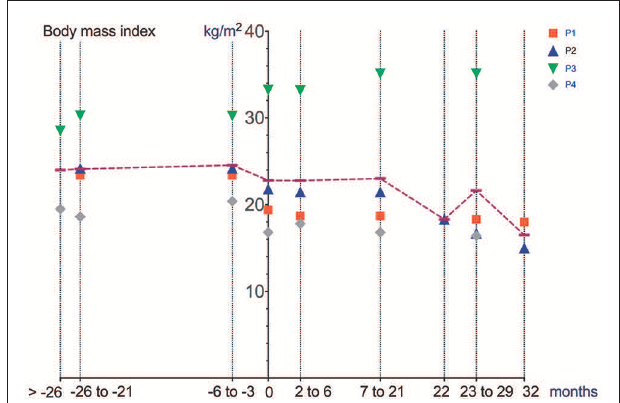
FIGURE 4 | BMI prior to and after initiation of Ataluren treatment. Graphic representation of BMI [kg/m 2 ] in relation to time. Time point 0 represents start of Ataluren treatment in all figures (P1 and P2 13th October 2015; P3 and P4 5th February 2016). Age at start of Ataluren: P1 and P2 14 10/12 years; P3 14 9/12 years; P4 11 11/12 years). Note that time period’s alternate because of a lack of data in some values.